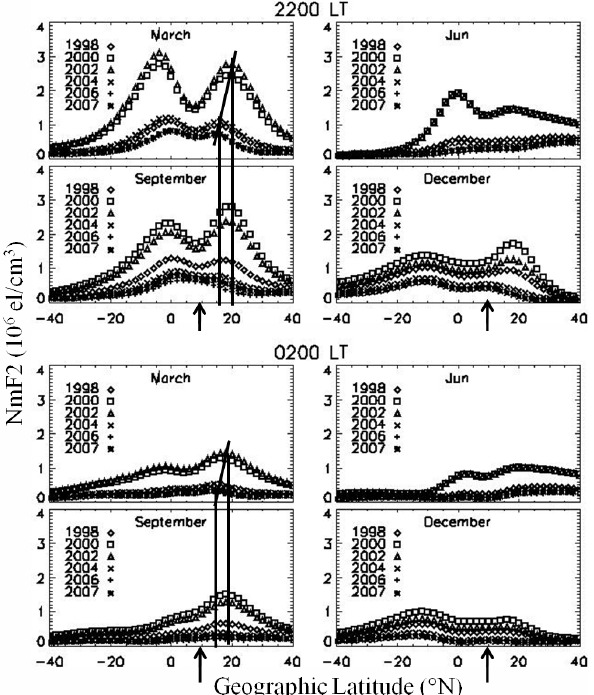
Fig. 7. The EIA crests over Taiwan longitude (121 ◦ E) at 22:00 and 02:00LT in different seasons during 1998–2007 as a function of latitude and Nm F2 using IRI07. The arrow denotes the magnetic equator.